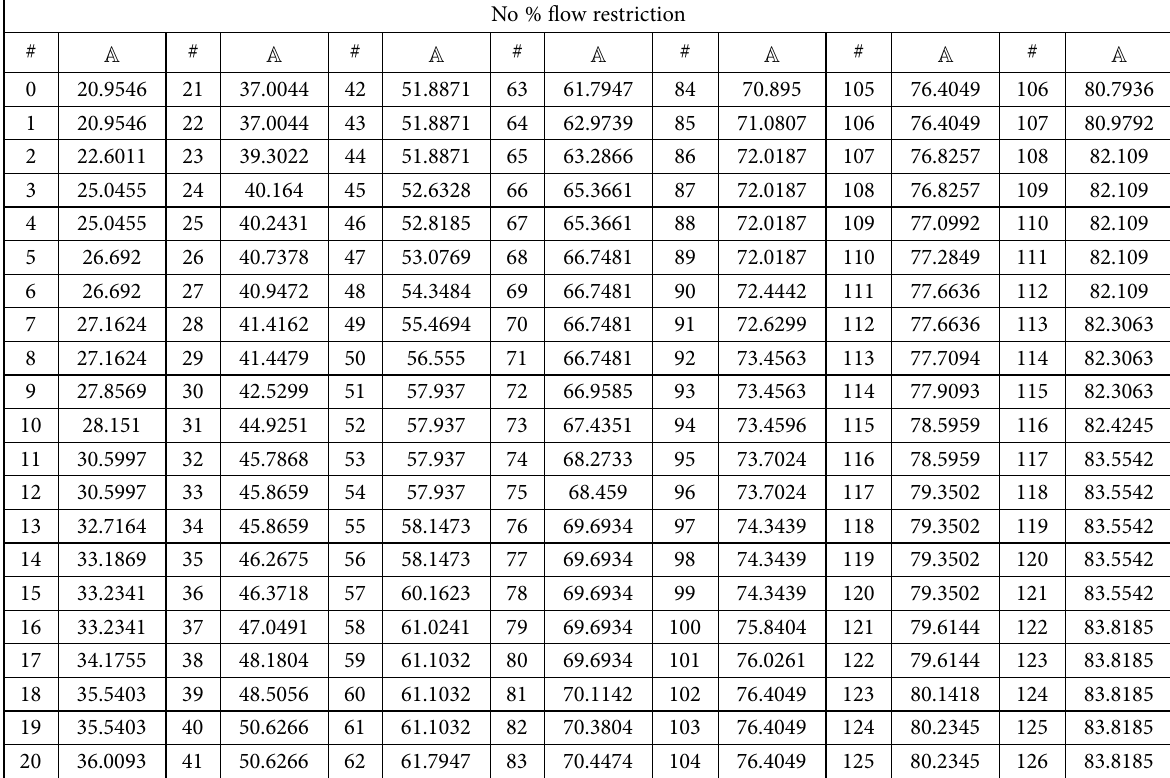
Table 14. Absolute capacity for incremental budget changes ( = max || 3 s ) No % flow